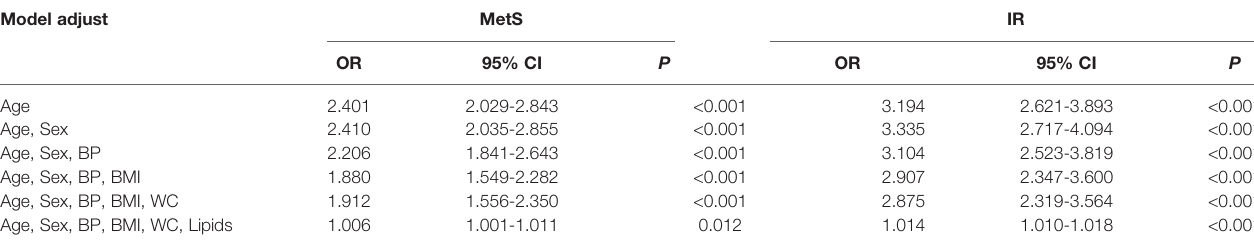
Results of multivariate logistic regression analysis are presented as the odds ratio of being in IR and MetS status increase in serum CTRP7. CI, con fi dence interval; OR, odds